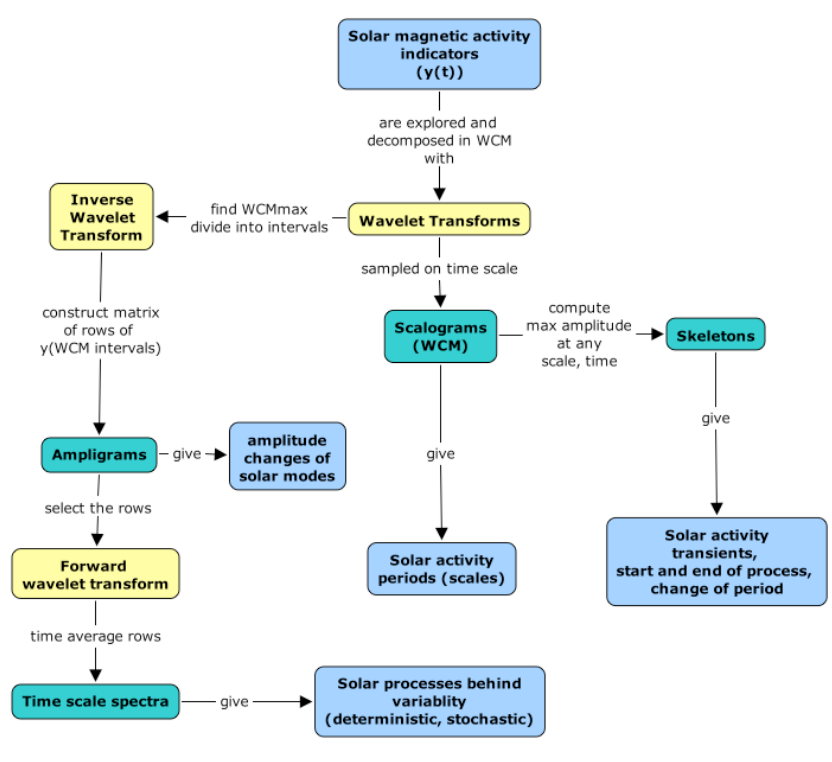
Fig. 2. The set of developed wavelet methods described in Lundstedt et al.